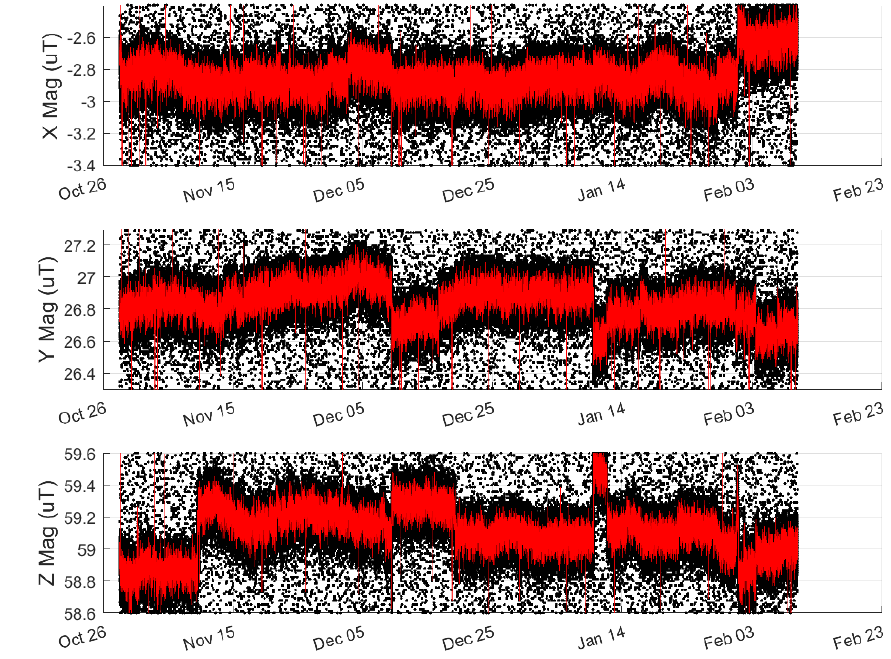
Figure A1. Stationary magnetometer data from 27 October 2022 to 10 February 2023. Raw data are depicted as black dots while median-filtered data (with a window size of five) is shown as a red line. As with Figure 5, there are several spurious measurements that span ± 3 µT. In Figure A1, the outliers are cropped out to emphasize the average signal. Figure A1 depicts a mean signal drift within 0.4 µT (for each axis) separated by irregular jumps in the measured signal. From November 2022 through 9 February 2023, there are seven distinct jumps in ˜ y z and fewer obvious jumps for ˜ y x and ˜ y y , respectively. These jumps are likely cased by small movements of the magnetometer (or the workbench above it) by others who use the